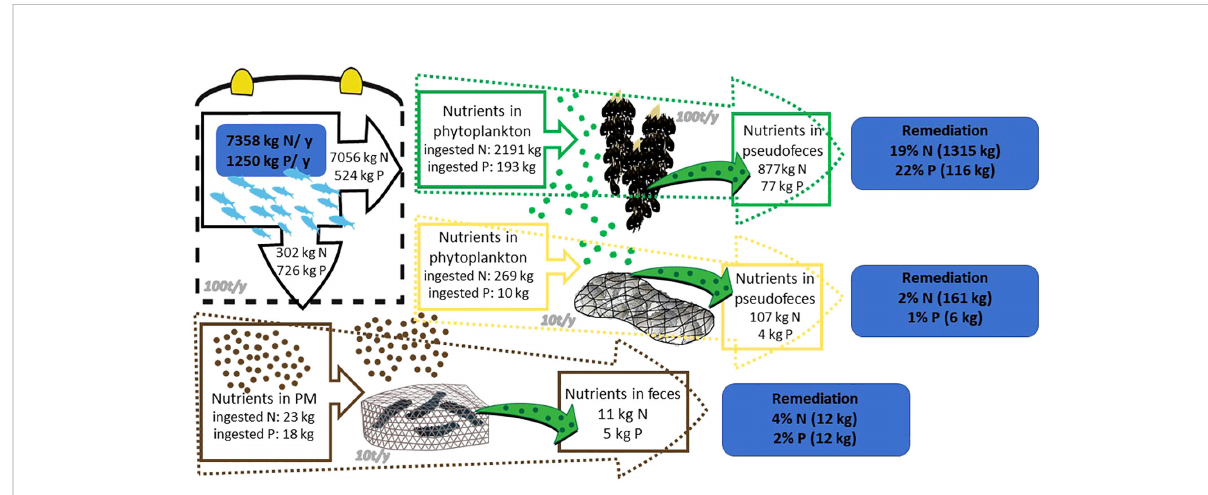
FIGURE 1 Remediation of dissolved nutrients from a fi sh farm with the help of mussel co-culture (green text box); pearl oyster co-culture (yellow text box) and sea cucumber co-culture (brown text box). Symbols provided by Integration and Application Network